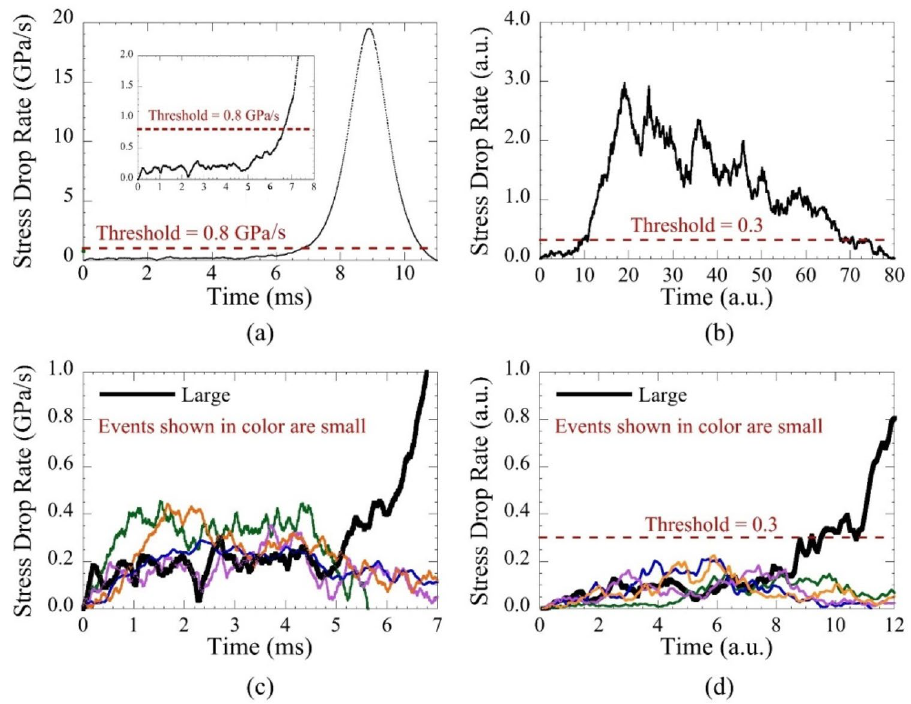
Figure 2. Experiment and simulation: The negative time derivative of stress as a function of time during large avalanches in Zr 45 Hf 12 Nb 5 Cu 15.4 Ni 12.6 Al 10 BMG ( a ) and in mean-field simulations ( b ). The dashed line is the threshold below which the “foot” or nucleation event of the large avalanche can be seen. Inset shows a magnification of the same foot. The same feet are shown plotted with small events with size within ± 5% of the respective foot for BMG ( c ) and simulations ( d ). The feet are shown in black; the small avalanches are shown in color. The feet are indistinguishable from their small events until the nucleation